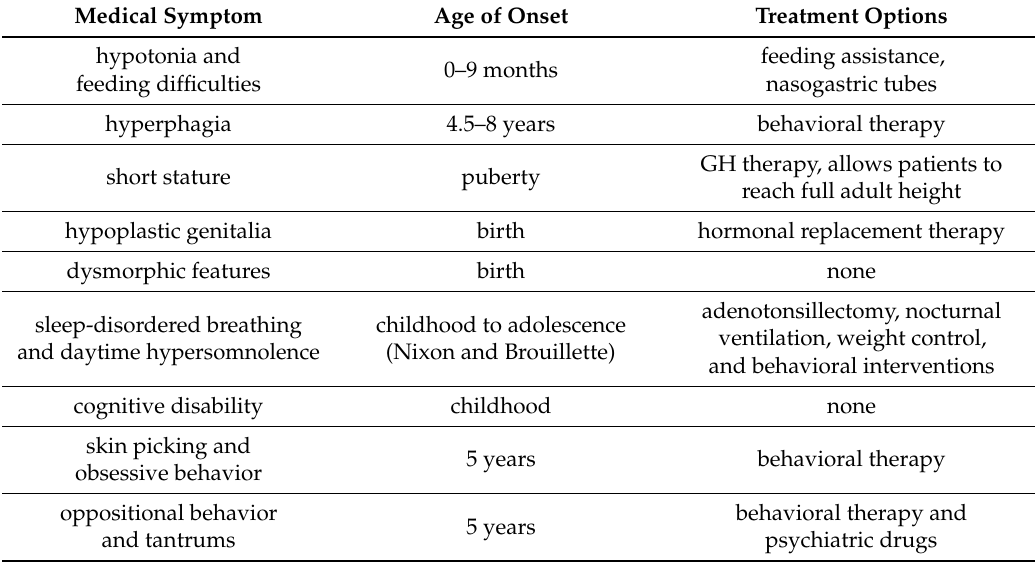
Table 1. Medical characteristics and treatment